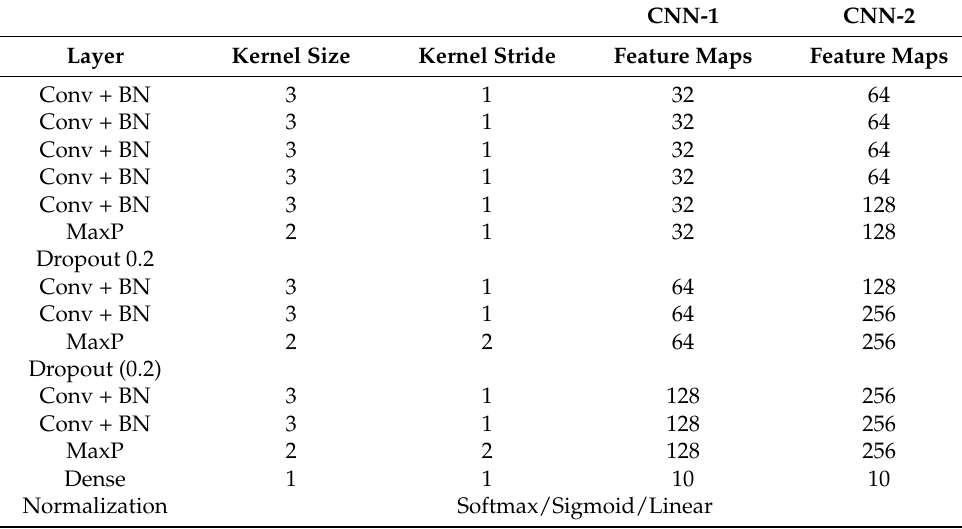
Table 3. CNN1 and CNN2 neural network